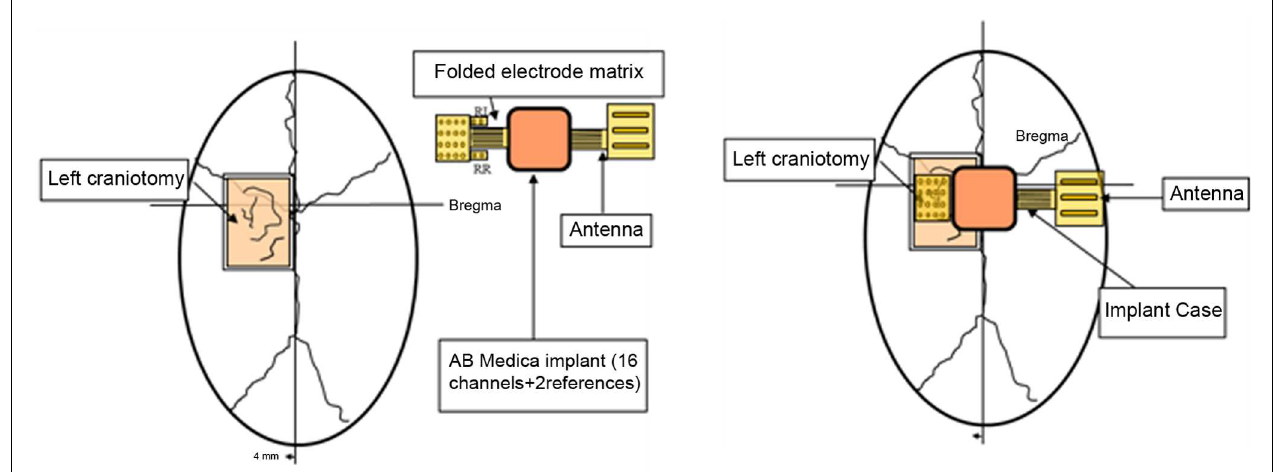
dura flap. In order to fit into the opening, we folded the portion connecting the grid and the case.The antenna of the device was in contact with the periosteal and the galea aponeurotica of the animal. All the system is covered by the animal skin.